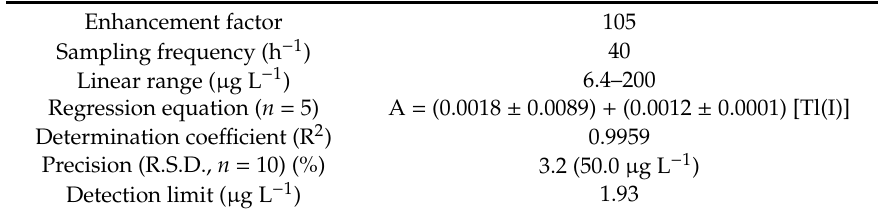
Table 2. Analytical figures of merit of the on-line FI–SPE–FAAS method for thallium determination.